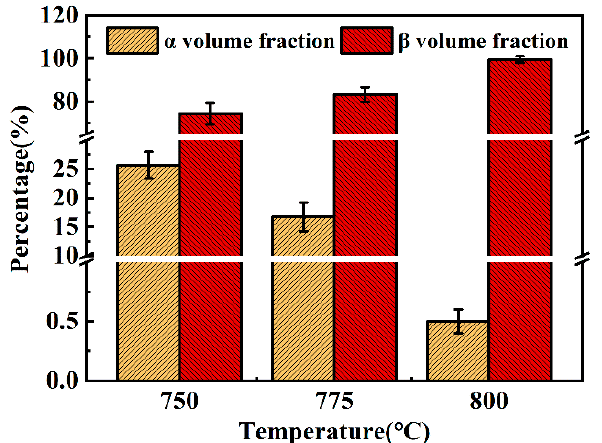
Figure 8. The variation of phase content with temperature at constant strain rate (0.01 s − 1 ).